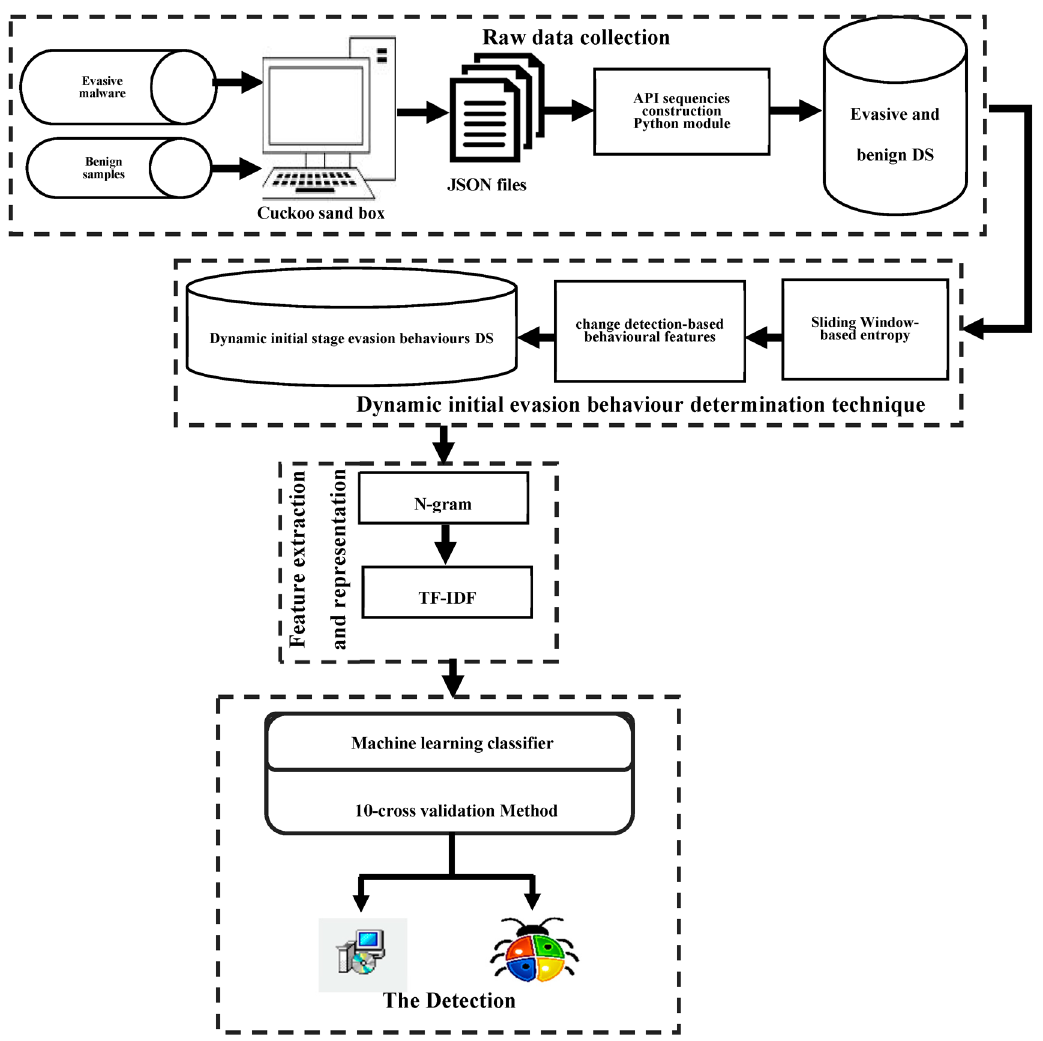
Figure 3. An overview of the framework.